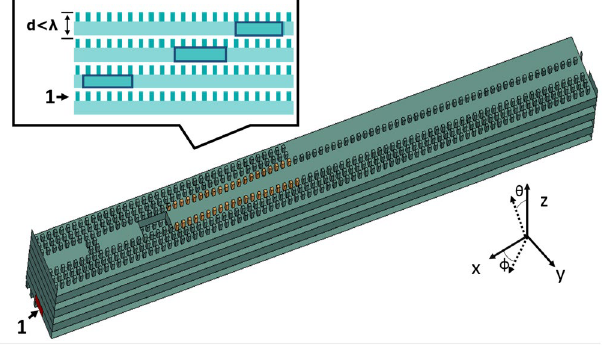
Figure 3. Perspective view of the array. In the inset a side view of the progressive manner the rectangular slots are placed. Number 1 indicates the waveguide feeding port. With orange are indicated the pins that are used to change the width of the groove, in order to correct the phase of each element before the radiating part of the